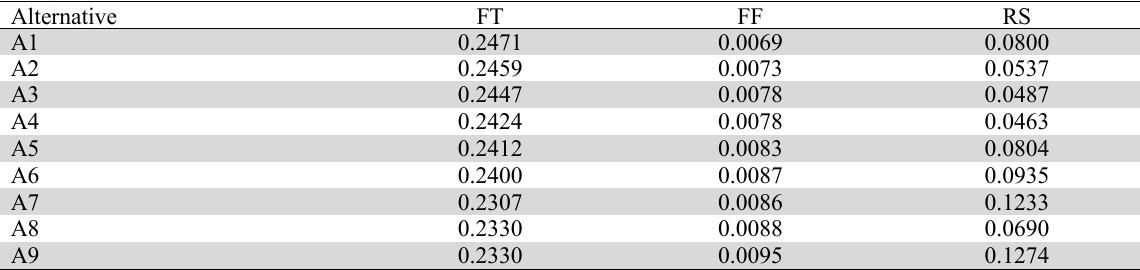
Weighted and normalized decision matrix (V ij )